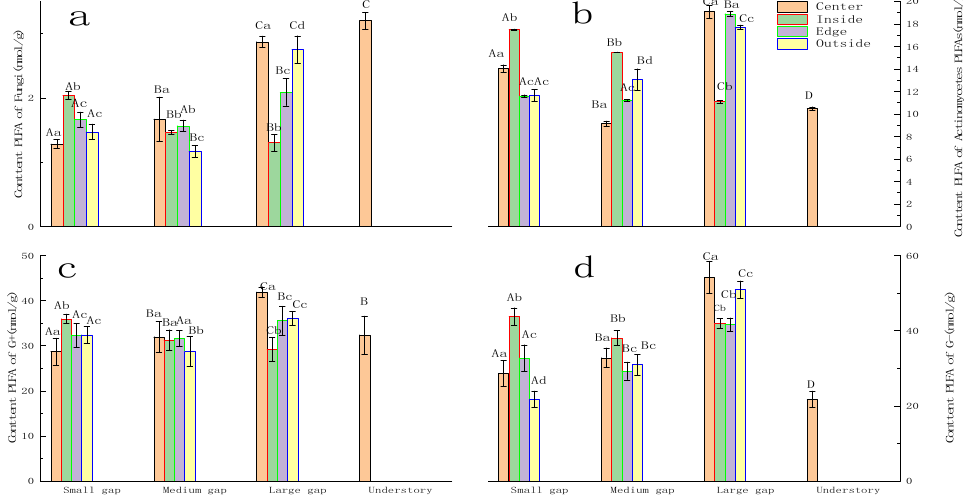
Figure 5. Differences in the contents of the soil microbial community in forest gaps (mean ± SE, 95% CI). Note: A, B, C, and D indicate differences in the same gap positions with different sizes; a, b, c, and d show differences in different positions within the same gap ( p <